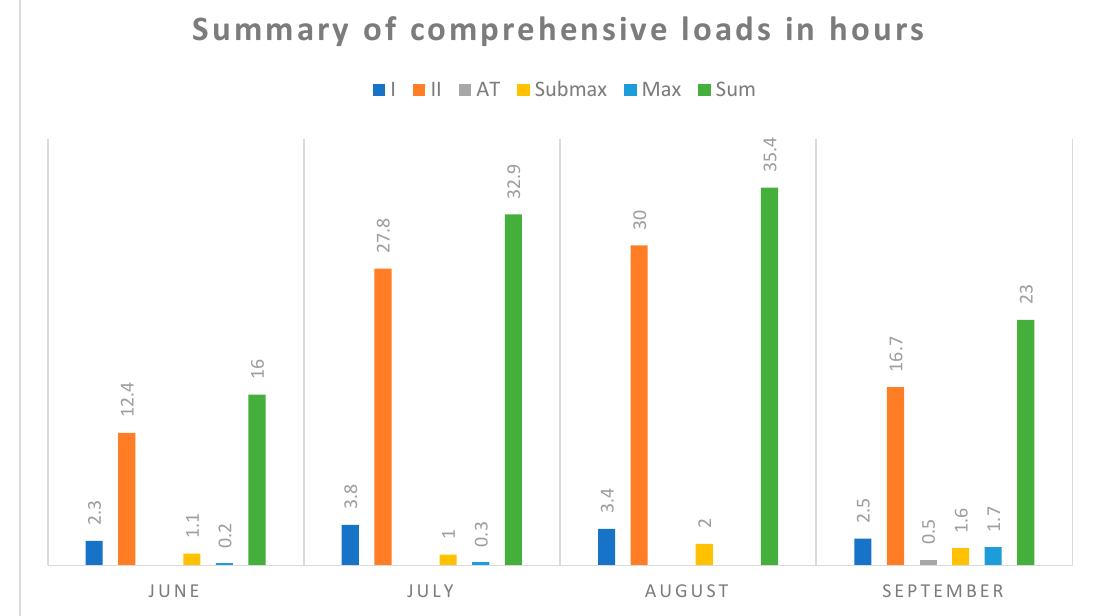
Figure 1. Monthly summary of comprehensive loads in hours .